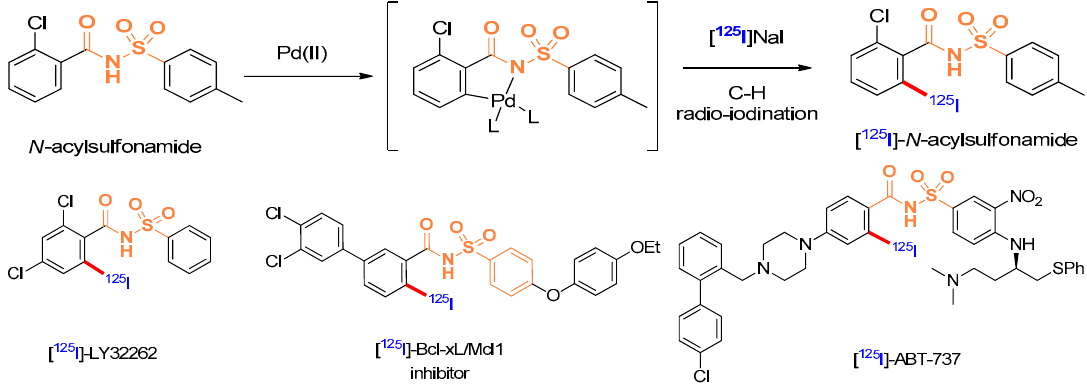
Figure 1. ( Upper ) Palladium-mediated C-H radioiodination. ( Lower ) Structures of [125I]-LY32262, a [125I]-Bcl-xL/Mcl1 and [125I]-ABT-737.